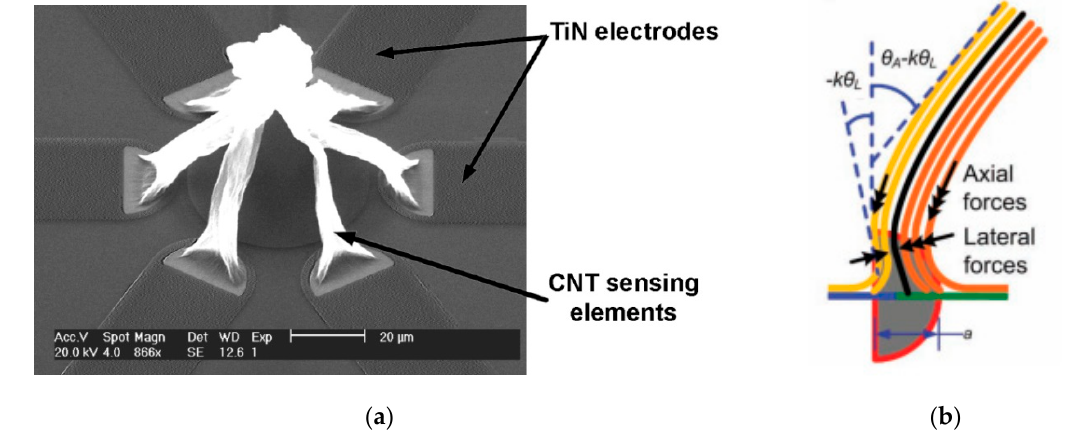
Figure 4. ( a ) SEM images of the CNT based temperature sensor investigated by de Volder . Reproduced from [29], courtesy of Michael De Volder; ( b ) forces applying on CNTs during self-assembly process from a semicircular area [77] Copyright © 2010 WILEY-VCH Verlag GmbH & Co. KGaA, Weinheim.